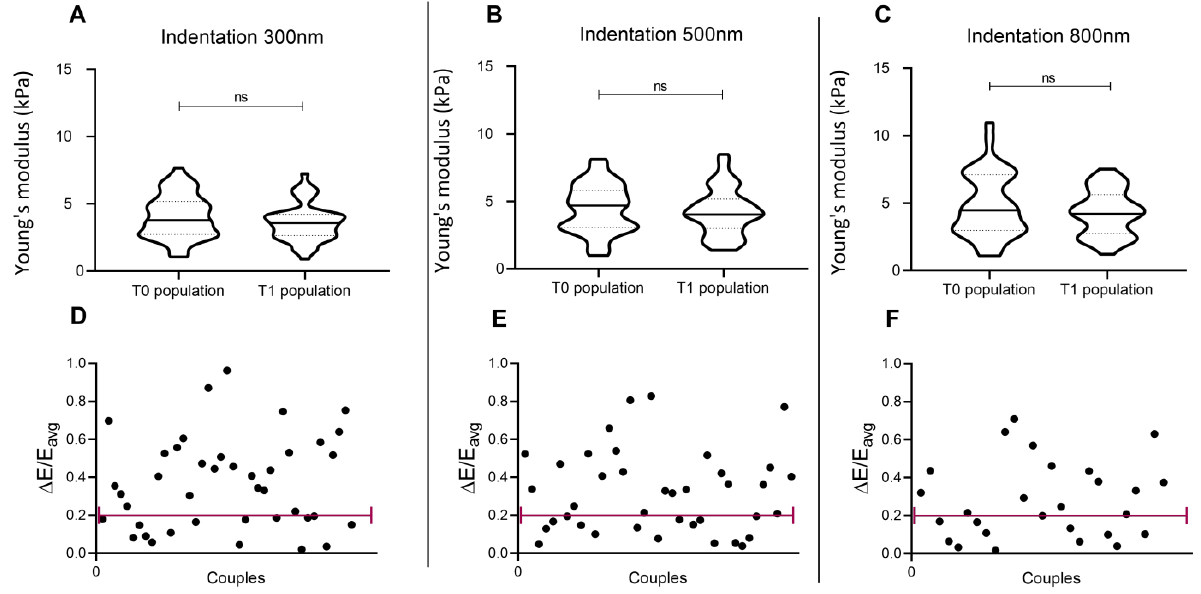
Figure 5. Indentation repeated in the same site of a single cell, 1 min after the first indentation (line 2). Panel ( A – C ): Distribution of elasticity values in the cell population, when indentation is performed at 300, 500, and 800 nm. ( D – F ): Normalised differences between elasticity values for each cell, obtained from the two consecutive indentations.